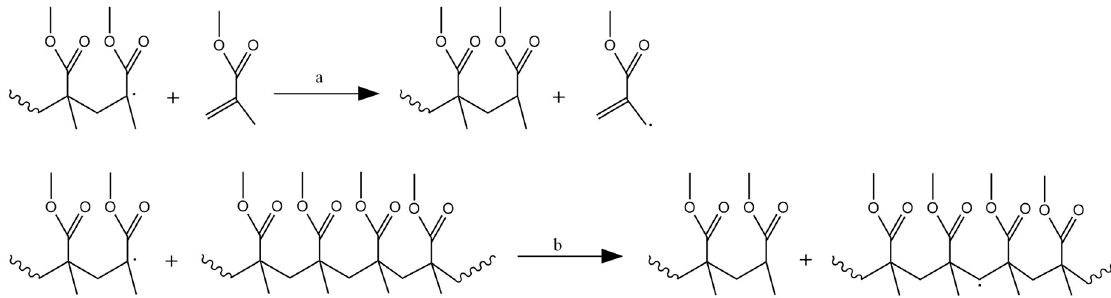
Figure 5. Additional reactions in free radical polymerization (FRP) of methyl methacrylate as opposed to the basic description displayed in Figure 3; focus on ( a ) chain transfer to monomer and ( b ) chain transfer to polymer twice with a head radical. The chain transfer to polymer reaction is however typically ignored.